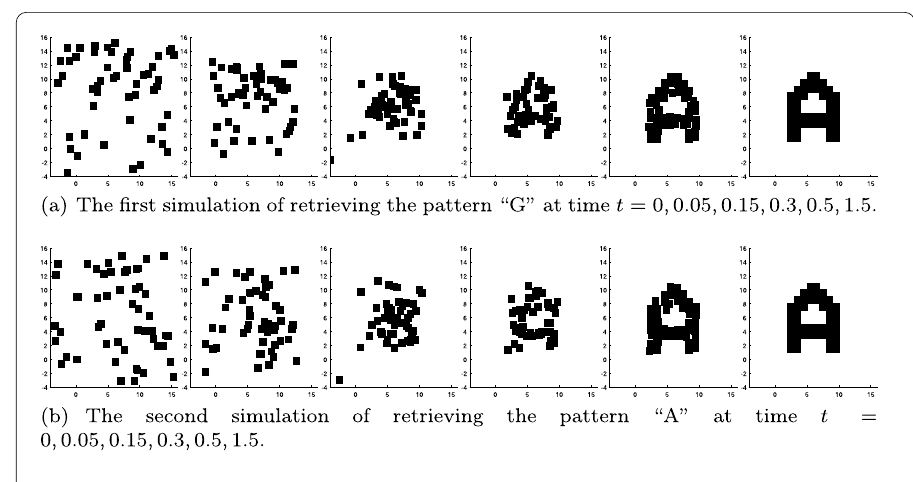
Figure 5 Two simulations of retrieving the pattern “A” with random initial values